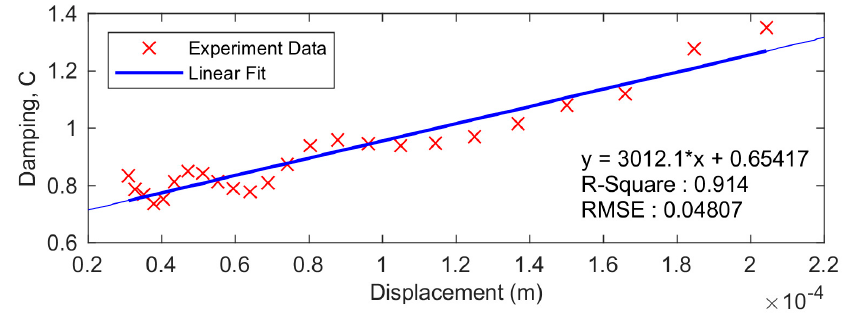
Figure 19. The curve fitting method to obtain the damping coefficients.